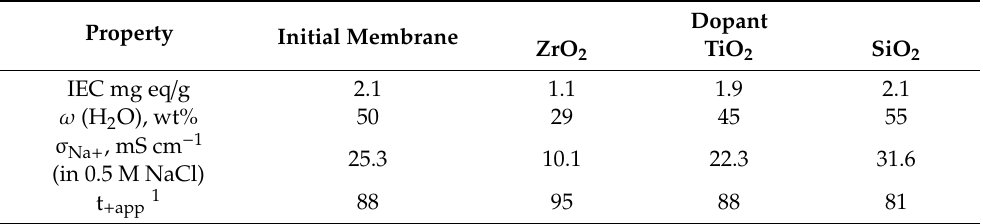
form with the dopant content of 8–10 wt%